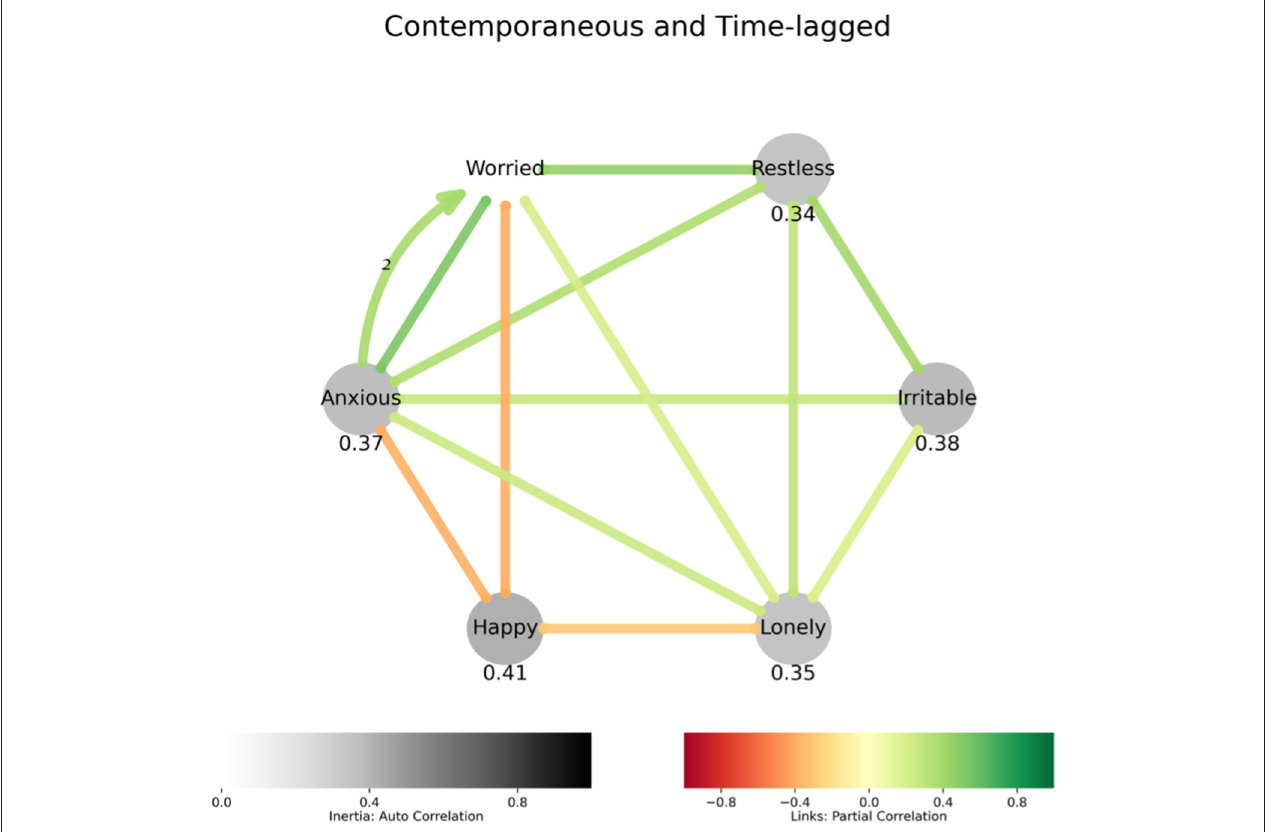
FIGURE 1 | Affect model describing how loneliness relates to affect: Undirected straight edges between variables indicate contemporaneous associations, and the directed labeled arcs represent lagged associations, with the label being the lag in multiples of sampling interval. The colors of the edges and the arcs represent negative (red) or positive (green) association. The variables with gray nodes indicate significant autocorrelation, or inertia, which can be interpreted as the values of these variables showing high resistance to change. If a variable measures polar quantity (happy-sad or relaxed-anxious), the variable is represented in the graph by the label to which higher values are assigned, and “how happy vs. sad were you” is simply “Happy.” Positive associations are in shades of green, and negative in shades of red. Lagged links are curved, have arrowheads and display lag in multiples of 8h. Negative emotional states are associated with loneliness. Inverse relationship between happy and loneliness is also expected. Anxiety and worry display a positive feedback